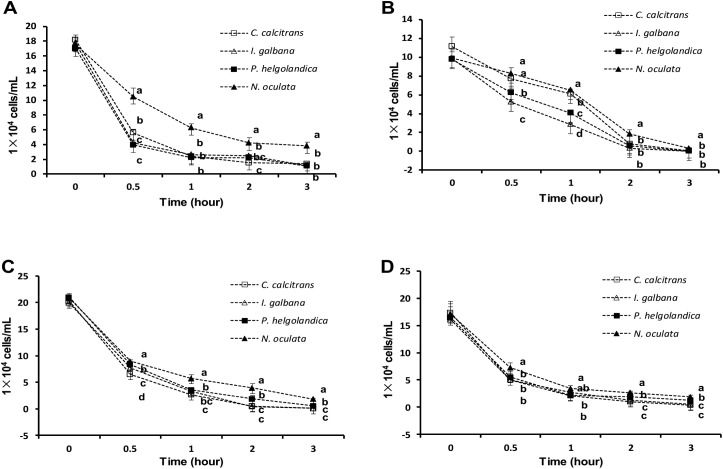
The concentration of each microalgal species (Chaetoceros calcitrans, Isochrysis galbana, Platymonas helgolandica and Nannochloropsis oculata) in the suspensions of Tegillarca gransa (A), Cyclina sinensis (B), Scapharca subcrenata (C) and Sinonovacula constricta (D) after 0 h, 0.5 h, 1 h, 2 h and 3 h of feeding. Values are expressed as the means ± SD (n = 3). Differences between algal species per time point were evaluated by one-way ANOVA, followed by the Duncan’s multiple range test. Labeled means in a column without a common letter differ, P<0.05.